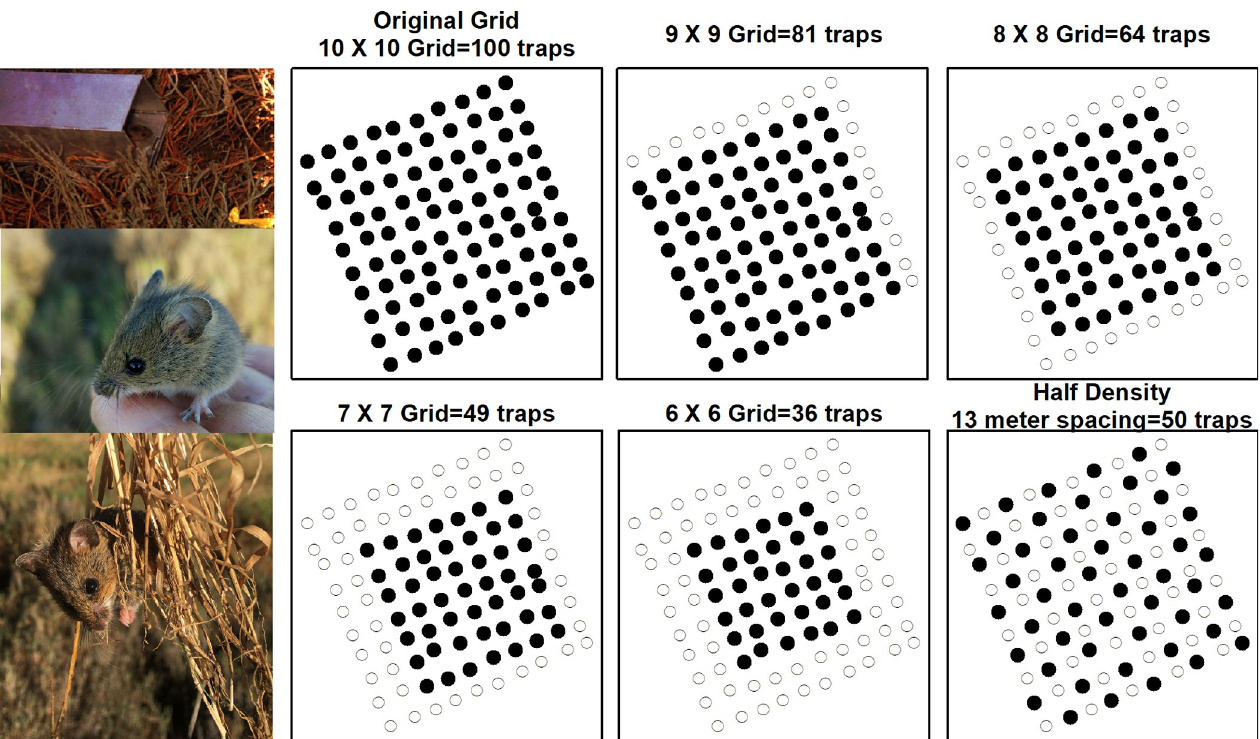
Fig 3. Crescent Unit trapping grid variations for subsampling reduced trapping designs. From top left to bottom right: Original field data collection layout of 10x10 grid, 9x9 grid, 8x8 grid, 7x7 grid, 6x6 grid, and a half density grid with 50 traps. Photos of small mammal trapping (photo credits: L. Thompson, I. Woo, and W.